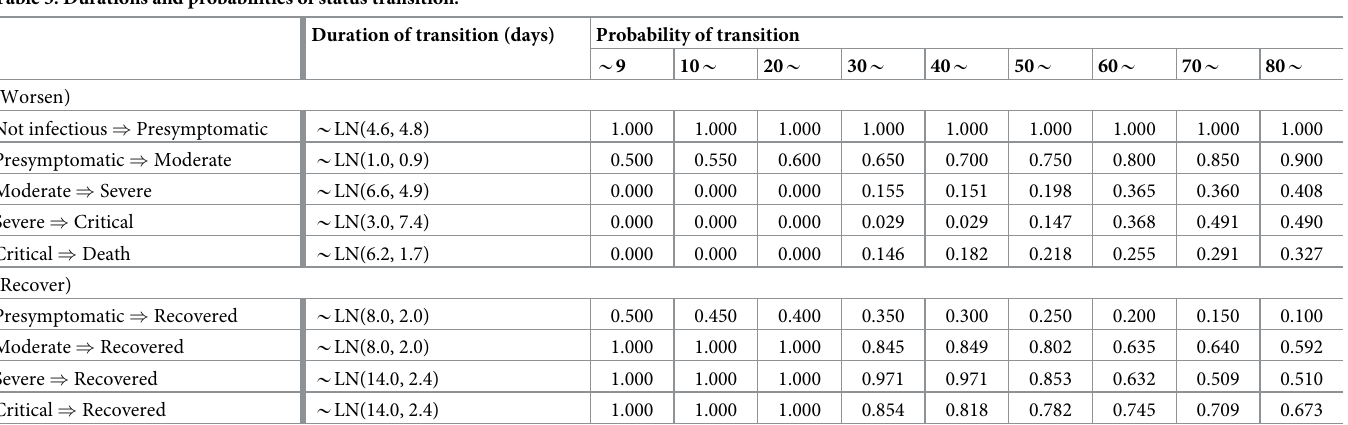
Table 3. Durations and probabilities of status